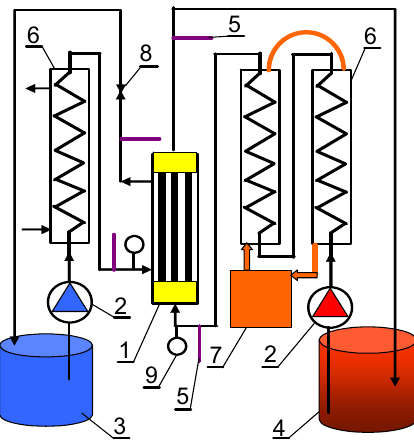
Figure 2. Schematic diagram of the DCMD installation. 1—capillary MD module, 2—peristaltic pump, 3—distillate tank, 4—feed tank, 5—thermometer, 6—glass spiral cooler, 7—thermostat, 8—valve, 9—manometer.